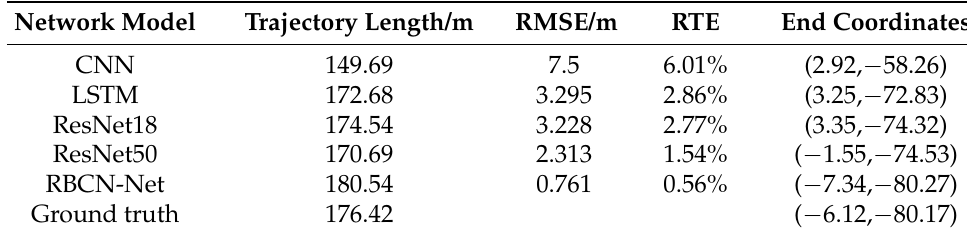
Table 4. Specific evaluation